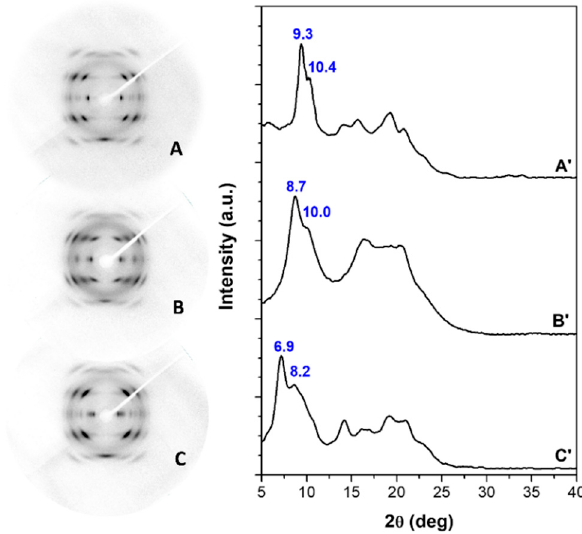
Figure 1. WAXD patterns of axially stretched s-PS films with a draw ratio of 4, exhibiting γ ( A , A’ ), δ ( B , B’ ) and ε ( C , C’ ) crystalline phases: ( A – C ) 2D patterns; ( A’ – C’ ) equatorial profiles of the 2D patterns.